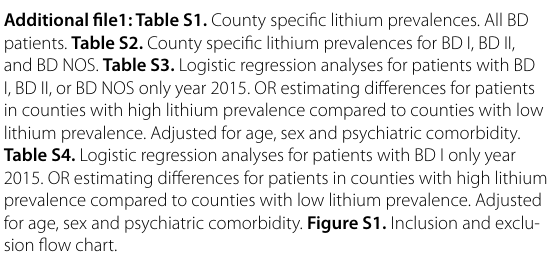
and BD NOS. Table S3. Logistic regression analyses for patients with BD I, BD II, or BD NOS only year 2015. OR estimating differences for patients in counties with high lithium prevalence compared to counties with low lithium prevalence. Adjusted for age, sex and psychiatric comorbidity. Table S4. Logistic regression analyses for patients with BD I only year 2015. OR estimating differences for patients in counties with high lithium prevalence compared to counties with low lithium prevalence. Adjusted for age, sex and psychiatric comorbidity. Figure S1. Inclusion and exclu- sion flow